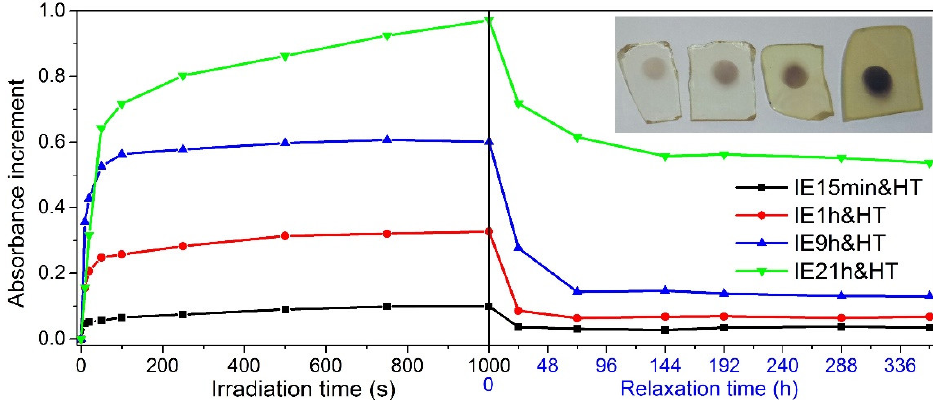
Figure 11. Coloring and bleaching kinetics for PTR-Br glass sample ion exchanged for different time and heat-treated at 500 °С for 9 h. Inset: photo of the samples after irradiation by the UV pulsed laser during 1000 s.